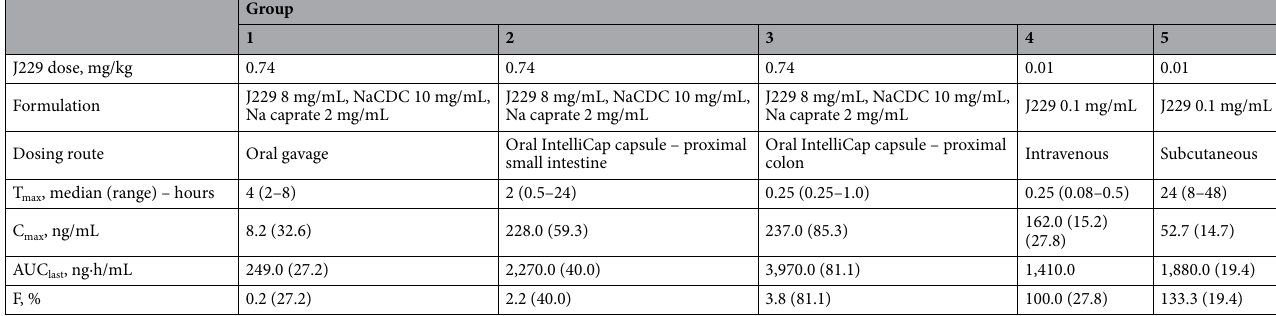
Table 2. Pharmacokinetic parameters of J229 delivered via different routes in dogs to determine site of absorption. Values are presented as arithmetic mean (% coefficient of variation) unless otherwise stated, n = 5 per group. AUC last , area under the curve from time 0 to last measurable concentration; C max , maximum serum concentration; F, bioavailability (systemic fraction); NaCDC, sodium chenodeoxycholate; T max , time to reach C max .